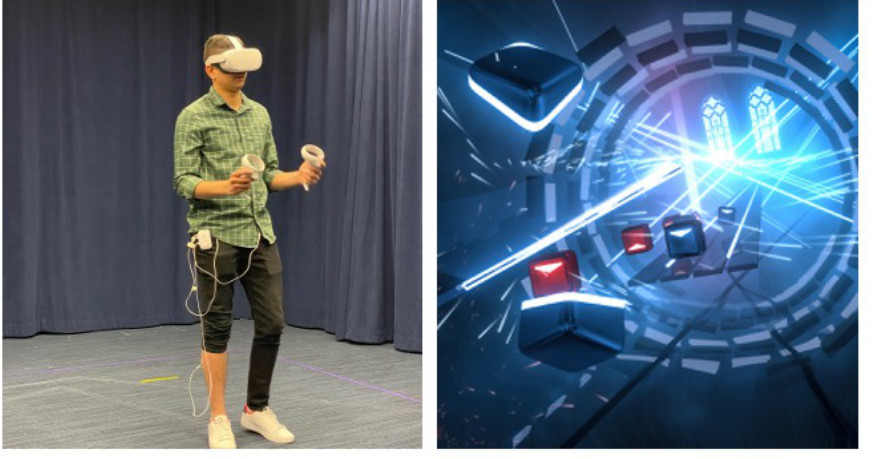
Figure 4. A figure showing a participant playing Beat Saber, the VR game used in the data collection step to induce cognitive